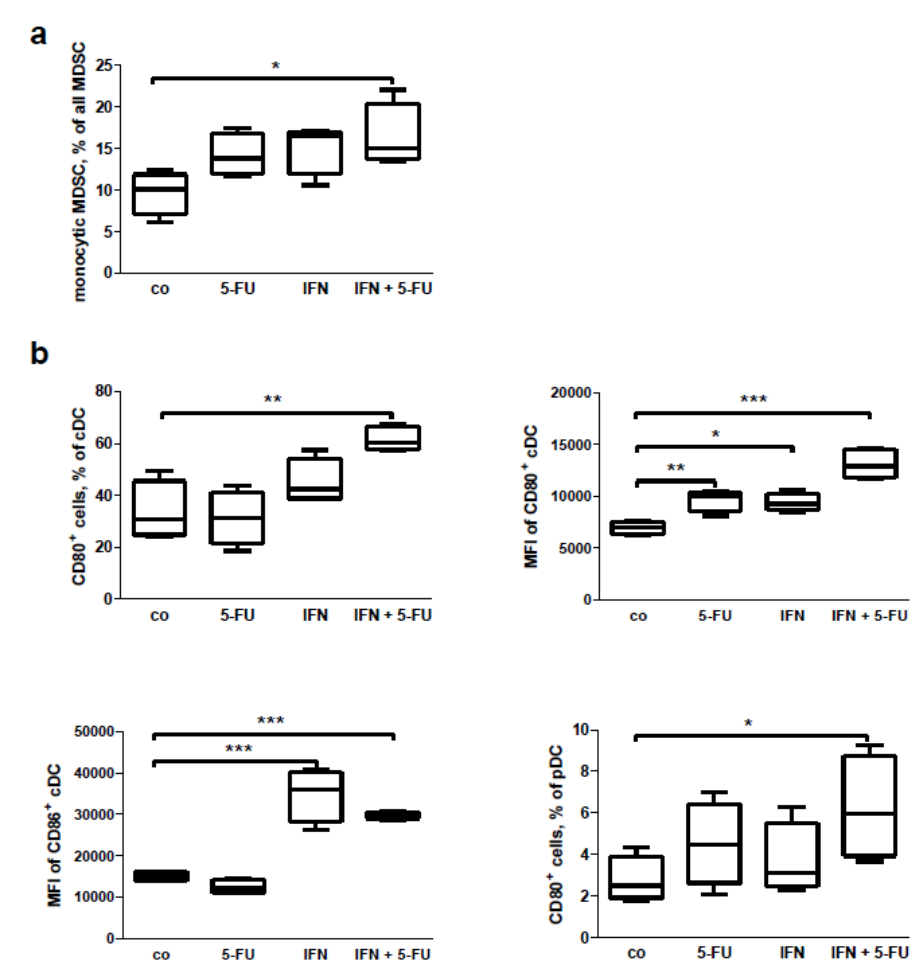
Figure 8. In vitro effects of therapies with IFN or 5-FU only or their combination on splenocytes from tumor-bearing mice: FACS analysis of ( a ) monocytic MDSC and ( b ) cDC and pDC. Results of four independent experiments are present, * p < 0.05, ** p < 0.01 and *** p < 0.001, co—control treated